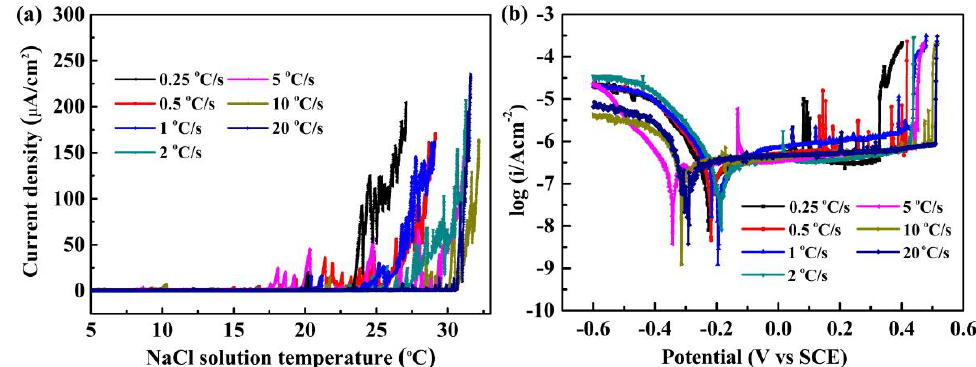
Figure 8. ( a ) The current density curve in the CPT tests under 250 mV SCE ; ( b ) the potentiodynamic polarization curves in the 3.5 wt.% NaCl solution for the 2002 specimens with different cooling rates.